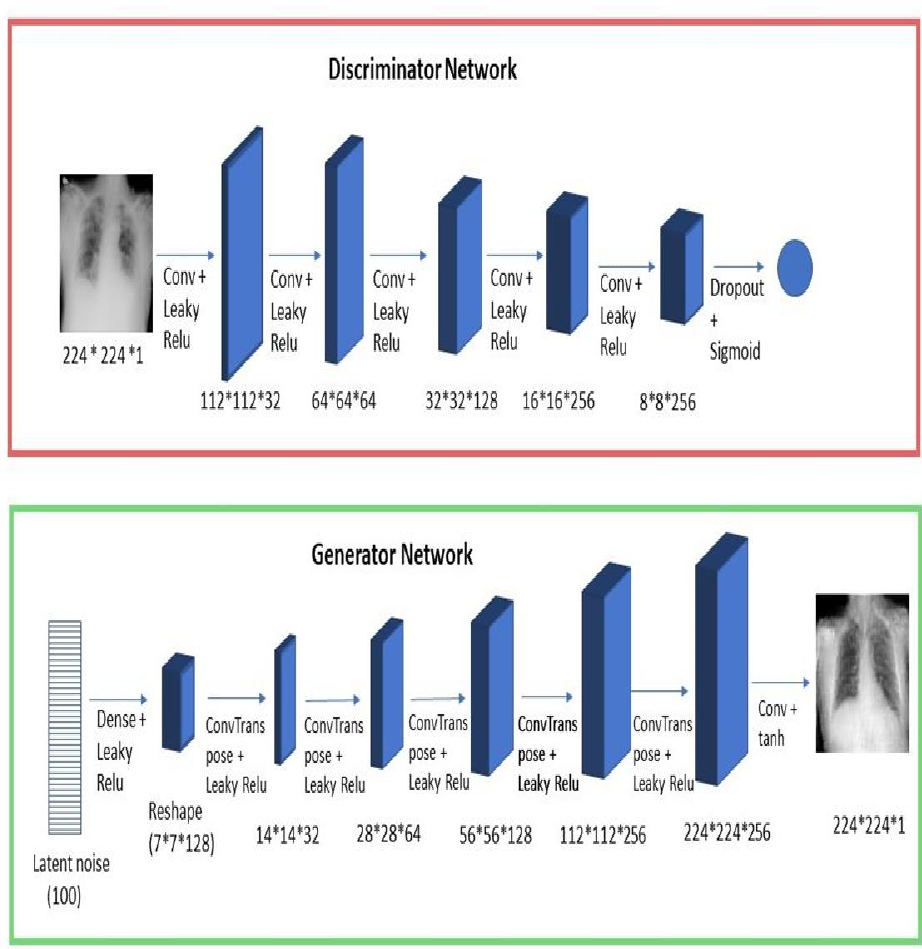
Figure 4. Discriminator and generator networks .